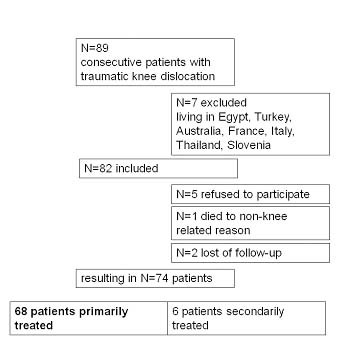
Patient selection.